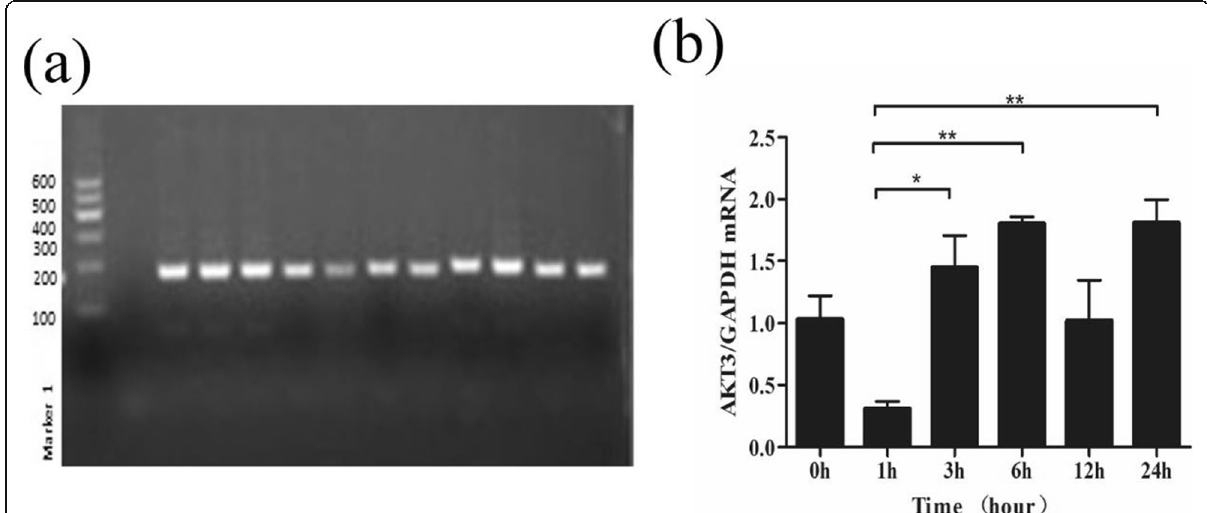
Fig. 6 a The result of PCR product for mRNA of various primers. b The AKT3 mRNA relative expression in bovine epithelium cell line was observed. The significantly different level of expression with time-dependent manner of LPS (10 ng/ml) treatment was found. The standard deviation (SD) is represented with error bars ( n = 3). To detect and clarify by using unpaired student ’ s t -test for significant differences as * P < 0.05, ** P < 0.01, and *** P < 0.001. ( n =